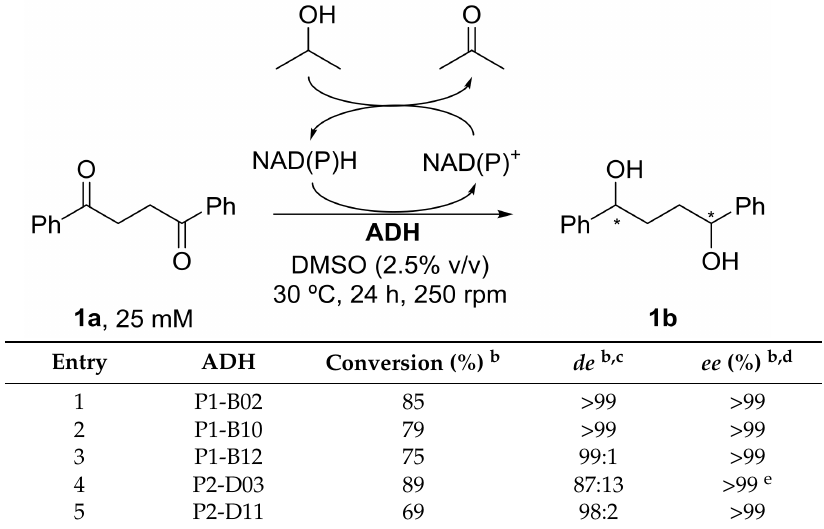
Table 2. Bioreduction of 1,4-diphenylbutane-1,4-dione ( 1a ) using commercially available alcohol dehydrogenases (ADHs) a